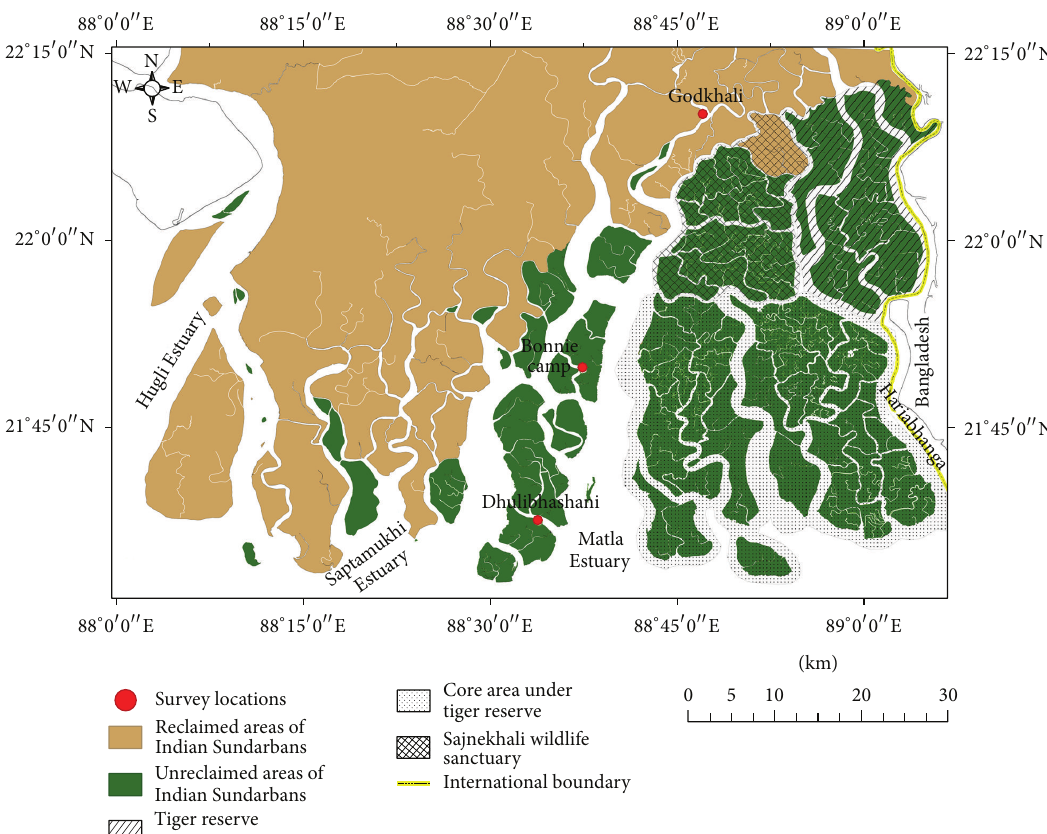
Figure 1: Geographical location of the sampling stations (Jharkhali-A, Sahidnagar-B, and Godkhali-C) in Indian Sundarbans. Coordinates of the sampling points and description of the stations are presented in Section